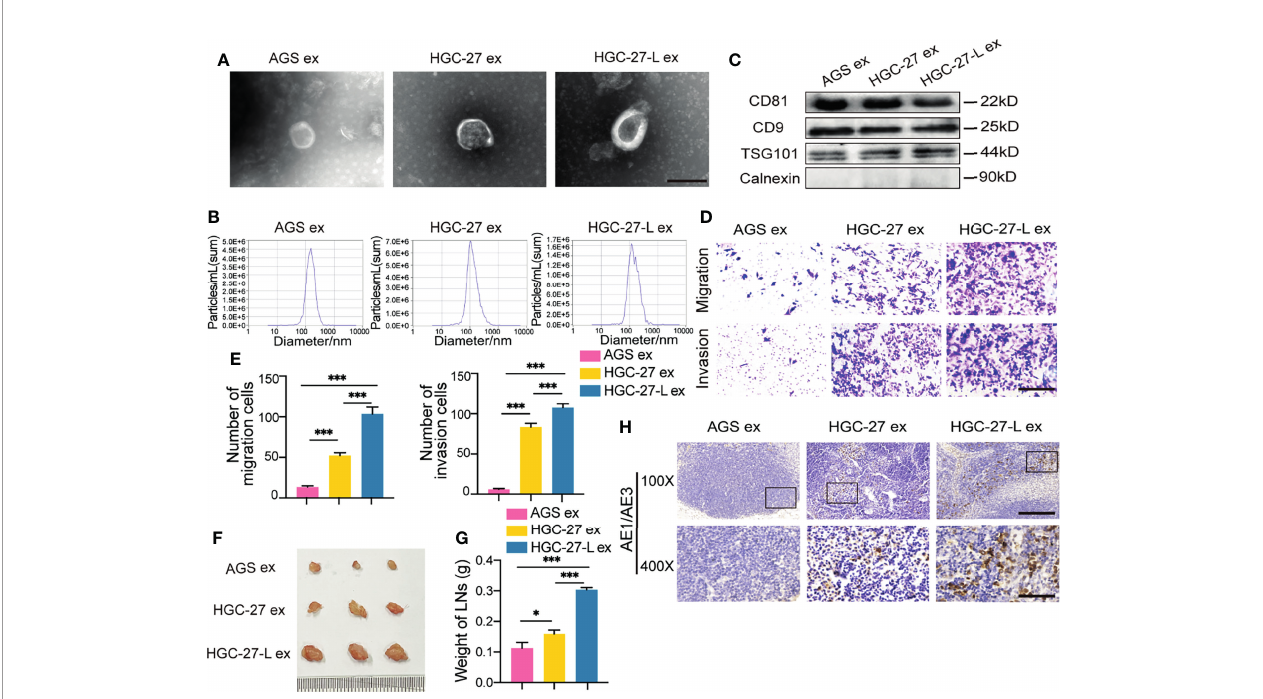
FIGURE 2 | Lymphatic metastatic GC cell-exosomes transmitted LNM phenotype to primary GC cells (A – C) Characterization of exosomes from lymphatic metastatic GC cells (HGC-27 and HGC-27-L) and primary GC cells (AGS). (A) TEM analysis (magni fi cation, 20000×; scale bars, 500 nm); (B) Nanosight detection; (C) Western blotting analysis; (D – H) Comparison of LNM capacity of AGS after treatment with GC cell-exosomes. (D, E) In vitro transwell analysis of migration and invasion capacity. (D) Images of migrated and invaded cells (magni fi cation, 200×; scale bars, 100 m m); (E) Cell count; (F – H) LNM capacity evaluation in vivo . (F) Pictures of popliteal LNs. Ruler unit, mm; (G) Weight of LNs; (H) Pancytokeratin AE1/AE3 staining (magni fi cation, 100×; scale bars, 200 m m; magni fi cation, 400×; scale bars, 50 m m). ex, exosomes. * P < 0.05; *** P <